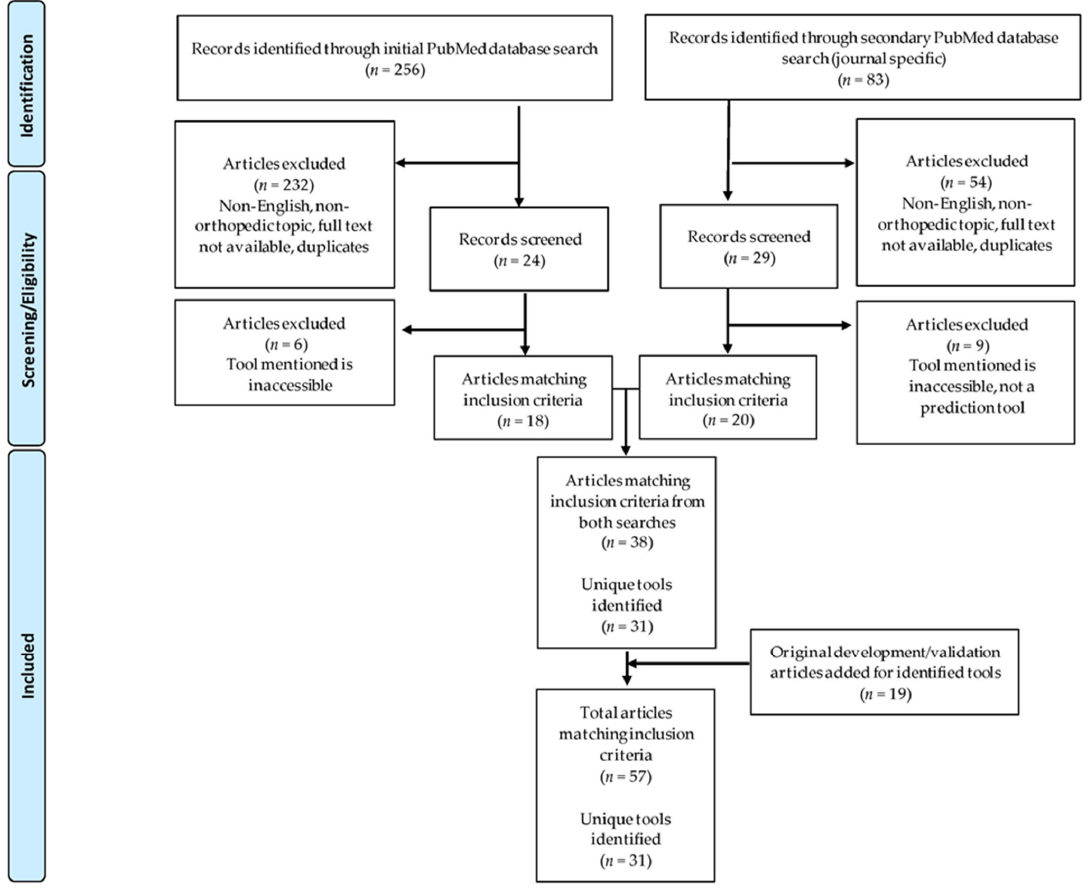
Figure A1. Search Strategy and Identification of Sources.